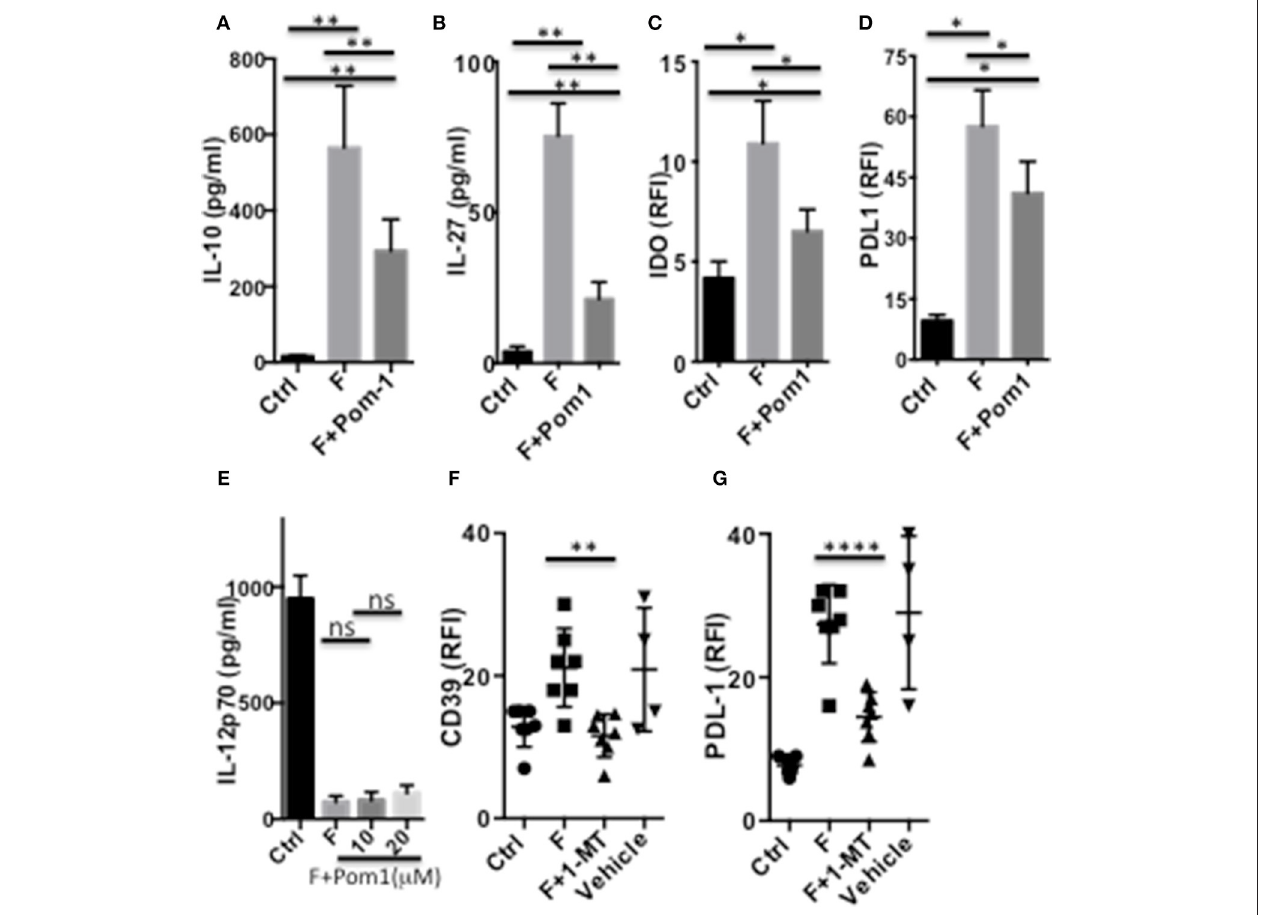
FIGURE 7 | CD39 and IDO1-dependent modulation of DC functions by F. prausnitzii . Secretion of IL-10 [ (A) n = 8] or IL-27 [ (B) n = 10] or expression of IDO1 [ (C) n = 4] or PDL-1 [ (D) n = 6] by DC incubated or not for the last 24h with F. prausnitzii , following or not a 45 min-incubation with the CD39 inhibitor Pom1 (10 µ M). (E) ( n = 3) LPS-induced IL-12-secretion by DC incubated, or not (Ctrl) with F. prausnitzii for 48h, following or not a 45 min-incubation with the Pom1 inhibitor. (F,G) : ( n = 5) CD39 and PDL-1 expression by DC incubated (F), or not (Ctrl) with F. prausnitzii for 24h, following or not a 45 min-incubation with the IDO1 inhibitor 1-MT. (A,B): Wilcoxon test, (E): Mann Whitney, (C,D,F,G) Paired t -test. * p < 0.05, ** p < 0.005, **** p <